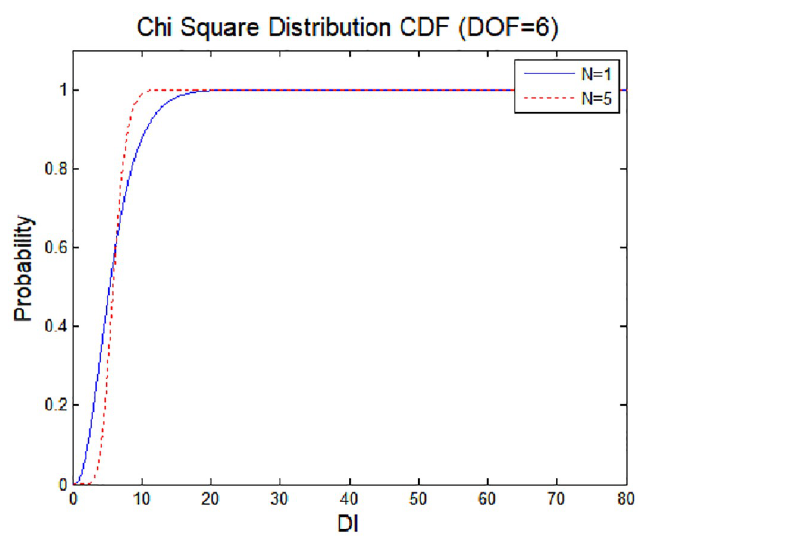
Fig 5. Chi-square distribution